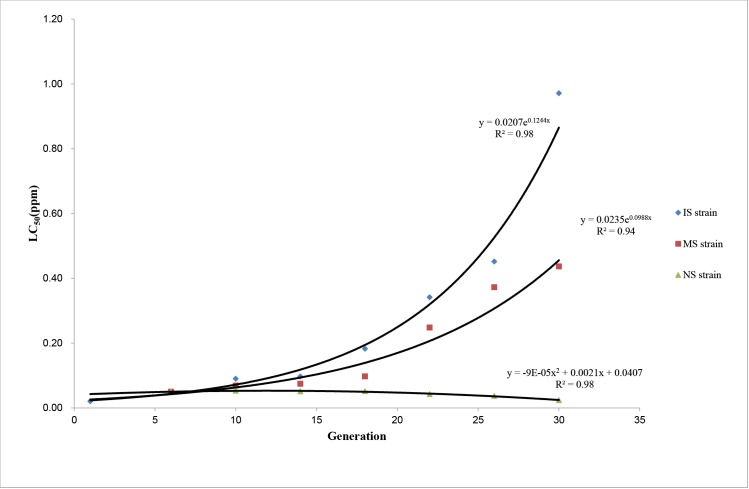
Scatter plot of the level of resistance and generation under different insecticide selection.In the IS strain, R2 = 0.98, P<0.0001; In the MS strain, R2 = 0.94, P<0.0001; In the NS strain, R2 = 0.98, P<0.0001.